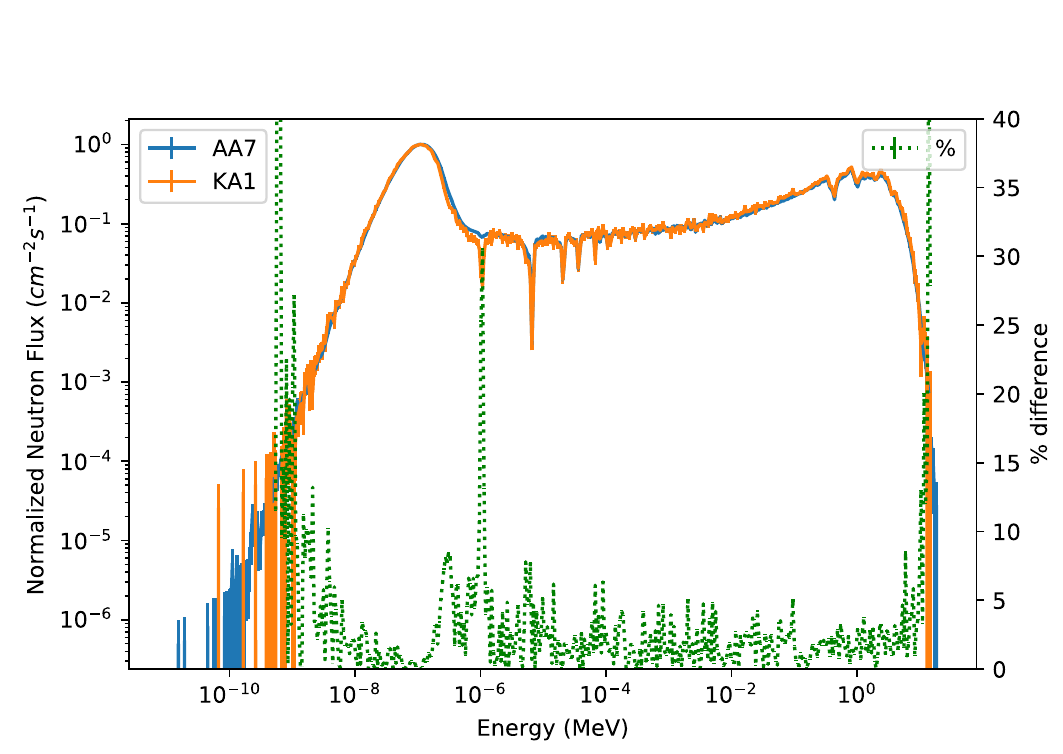
Figure 3: Comparison of Normalized Neutron Flux Spectra for Bundles AA7 and KA1 Highlighting the Differences in Discrete Neutron Energy